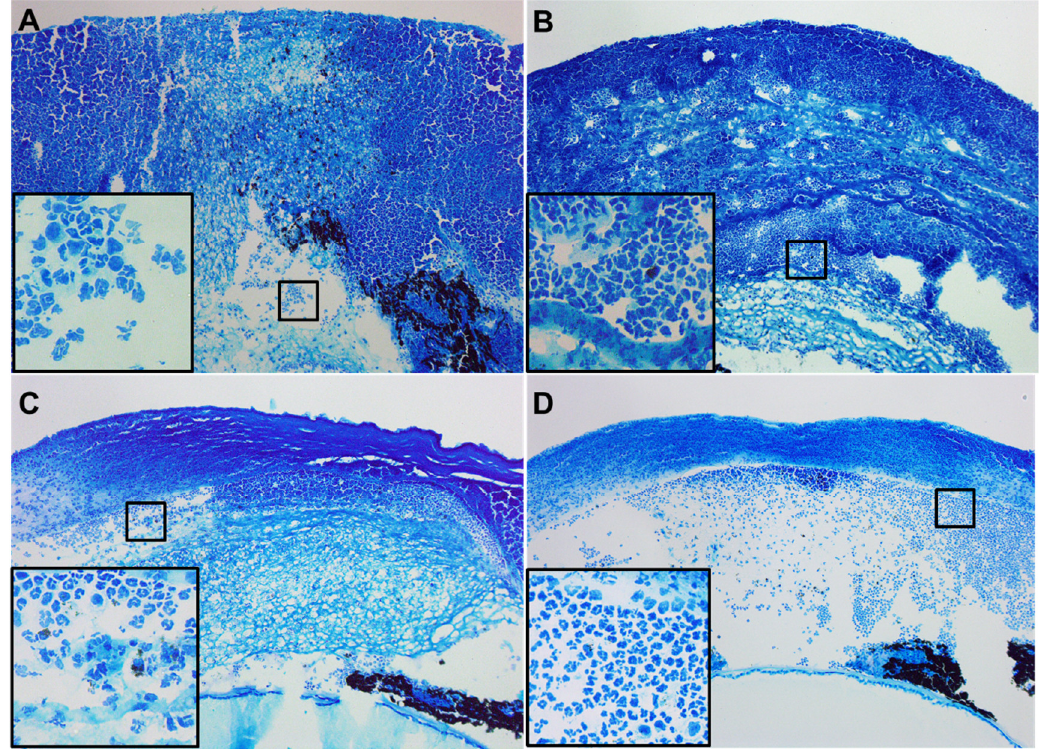
Figure 2. Histopathology at 5 days p.i. following PBS ( A ), Tβ4 ( B ), ciprofloxacin ( C ), and Tβ4 + ciprofloxacin ( D ) treatment. Whole eyes were sectioned (1.5 μm thick) and stained with Richardson’s ciprofloxacin ( D ) treatment. Whole eyes were sectioned (1.5 µ m thick) and stained with Richardson’s stain. N = 5 corneas /group. Magnification = ×10; (×40, insets). stain. N = 5 corneas /group. Magnification = × 10; ( × 40,